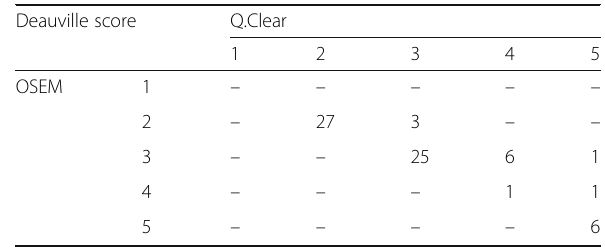
Table 3 Deauville scores obtained using Q.Clear and OSEM after completed